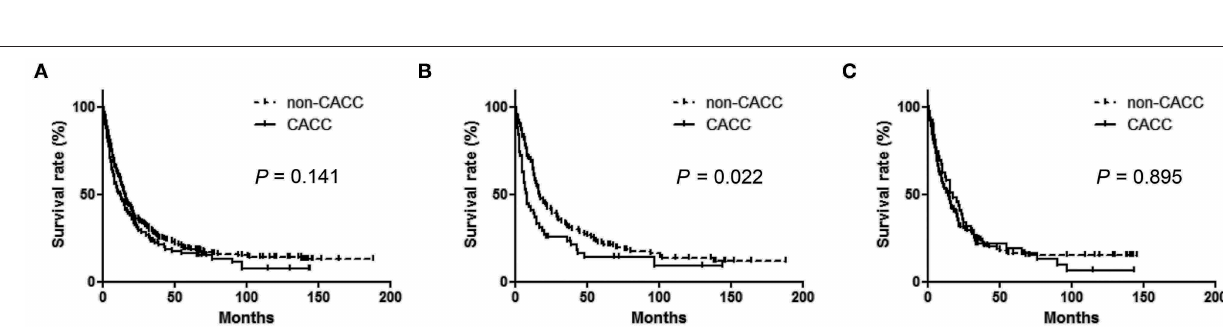
FIGURE 2 | Kaplan-Meier curves according to Clonorchis sinensis infection in analysis: (A) The entire cohort (B) Age < 64 years (C) Age ≥ 64 years. Comparison of median survival time in patients younger than 64 years old between Clonorchis sinensis -associated cholangiocarcinoma (CACC) and non- Clonorchis sinensis -associated cholangiocarcinoma